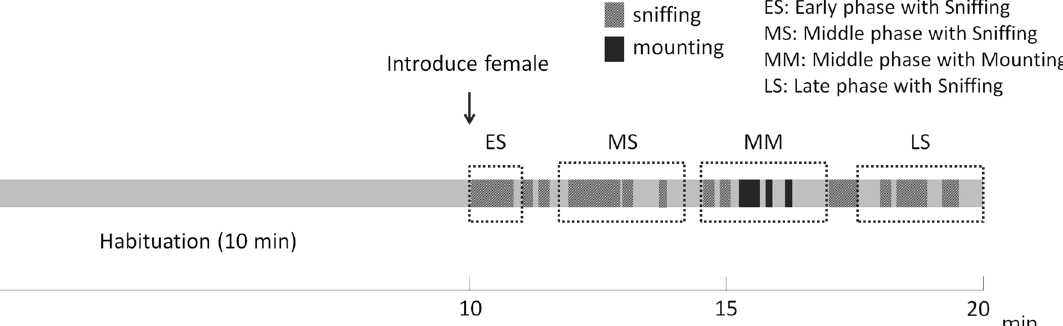
Fig 1. Example of the experimental procedure to record vocalization and behavior. Ten minutes after a male had been placed in a recording cage for habituation, a female was introduced into the cage and ultrasonic vocalizations were recorded for 10 min. We divided the vocalizations into four categories based on behavior and contact time (see text for